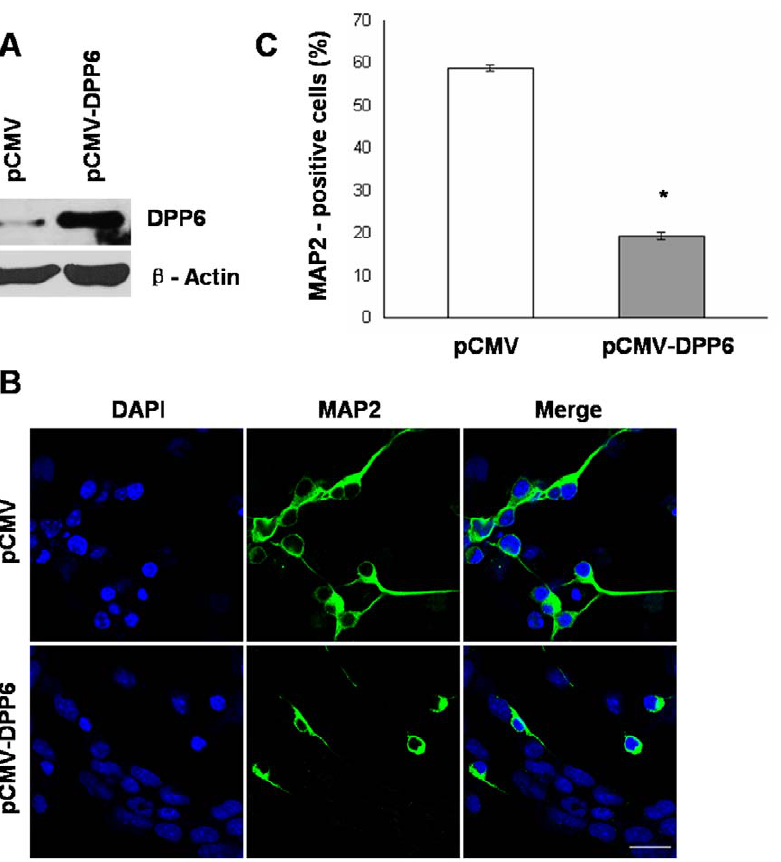
Figure 5. Ectopic expression of Dpp6 results in impaired neuronal differentiation of P19 cells. A, Western blot analysis showing expression of Dpp6 protein in stably transfected P19 cells either with empty vector (pCMV) or Dpp6 expression vector (pCMV-Dpp6). B, Stably transfected P19 cells with either pCMV or pCMV-Dpp6 were treated with RA initially for 2 days and further cultured for 4 days without RA treatment were immunostained with MAP-2 antibody and counterstained using DAPI. C, Graph showing % MAP-2 positive cells after 6 days differentiation of control and Dpp6 expressing P19 cells. At least 500 cells were counted from each group. Values represent mean of three independent experiments and error bars represent 6 SEM. *P , 0.05 versus the empty vector control. Scale bar: 20 m